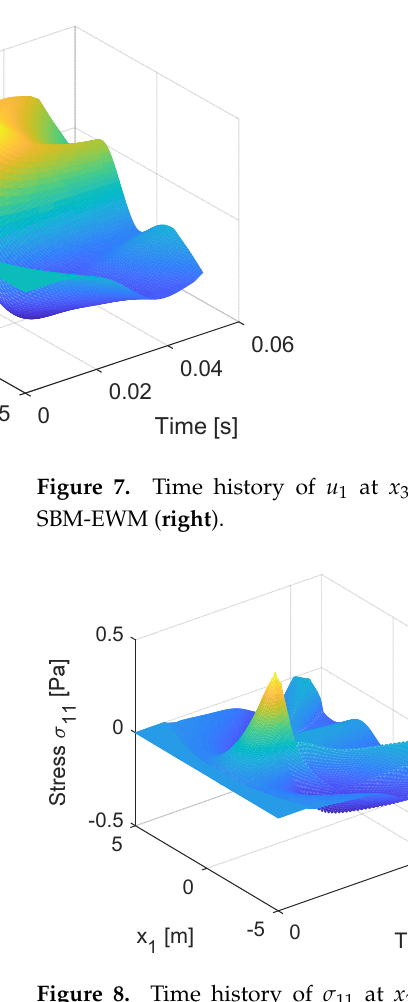
Figure 9. Numerical comparison between the MFS and SBM. 5.3. A Tunnel Embedded in a Saturated Poroelastic Half-Space In this example, a model of a semi-circular tunnel embedded in a saturated poroelas- tic half-space in Figure 10 is considered. The radius of the tunnel is R = 3 m and the depth of invert of the tunnel is H = 6 m. A triangularly distributed transient load is imposed at the invert of the tunnel. The ground and the surface of the tunnel are set as permeable. Thus, the boundary conditions are expressed as (